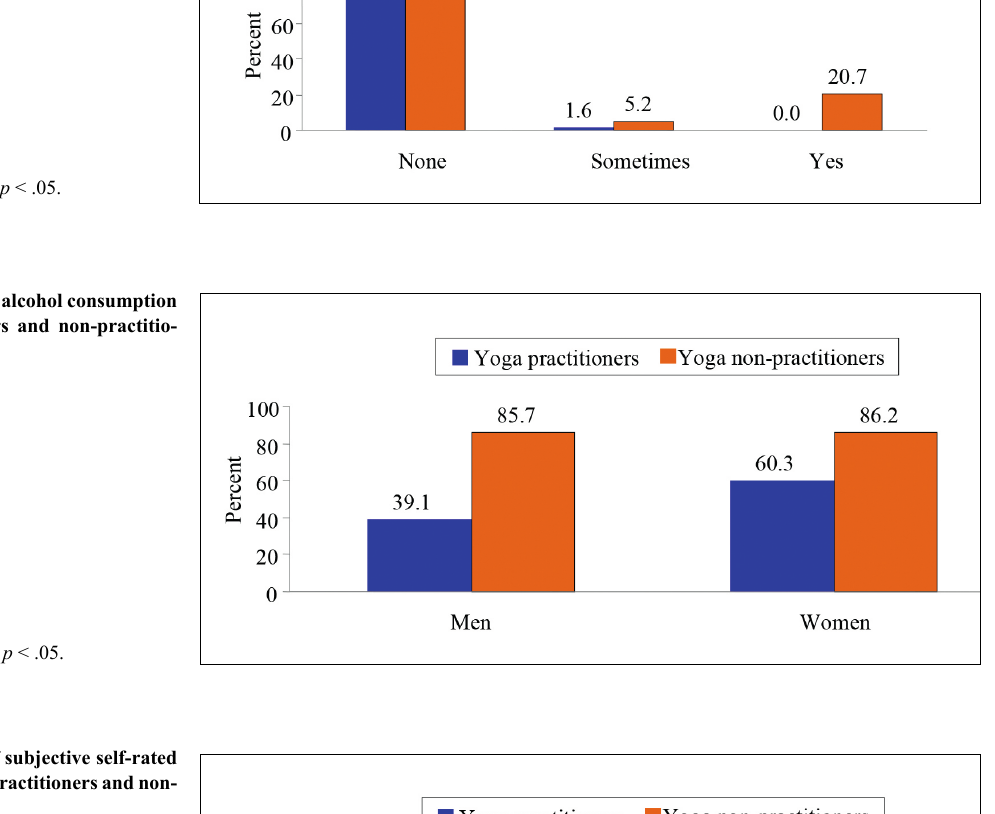
Figure 11. Pattern of subjective self-rated health in men yoga practitioners and non- practitioners